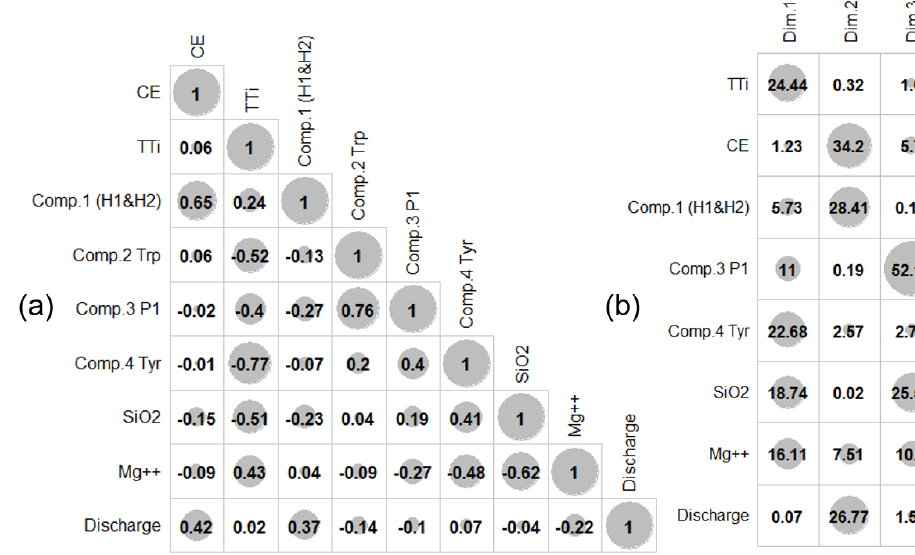
Figure 5. Correlation matrix of variables (a) and variable contributions to the three principal components of PCA (b)